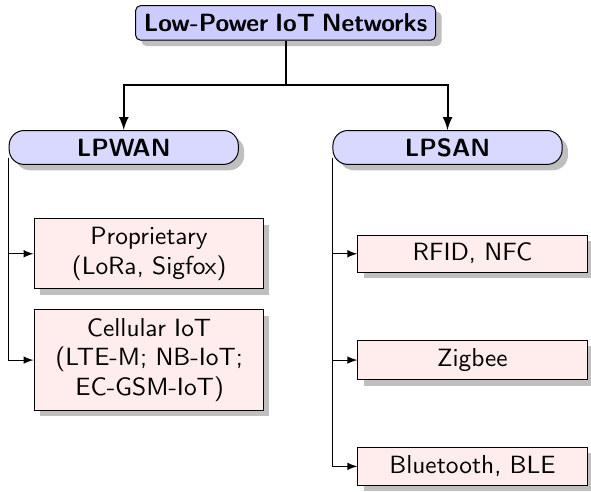
Figure 1. Low-Power Internet of Things (IoT)